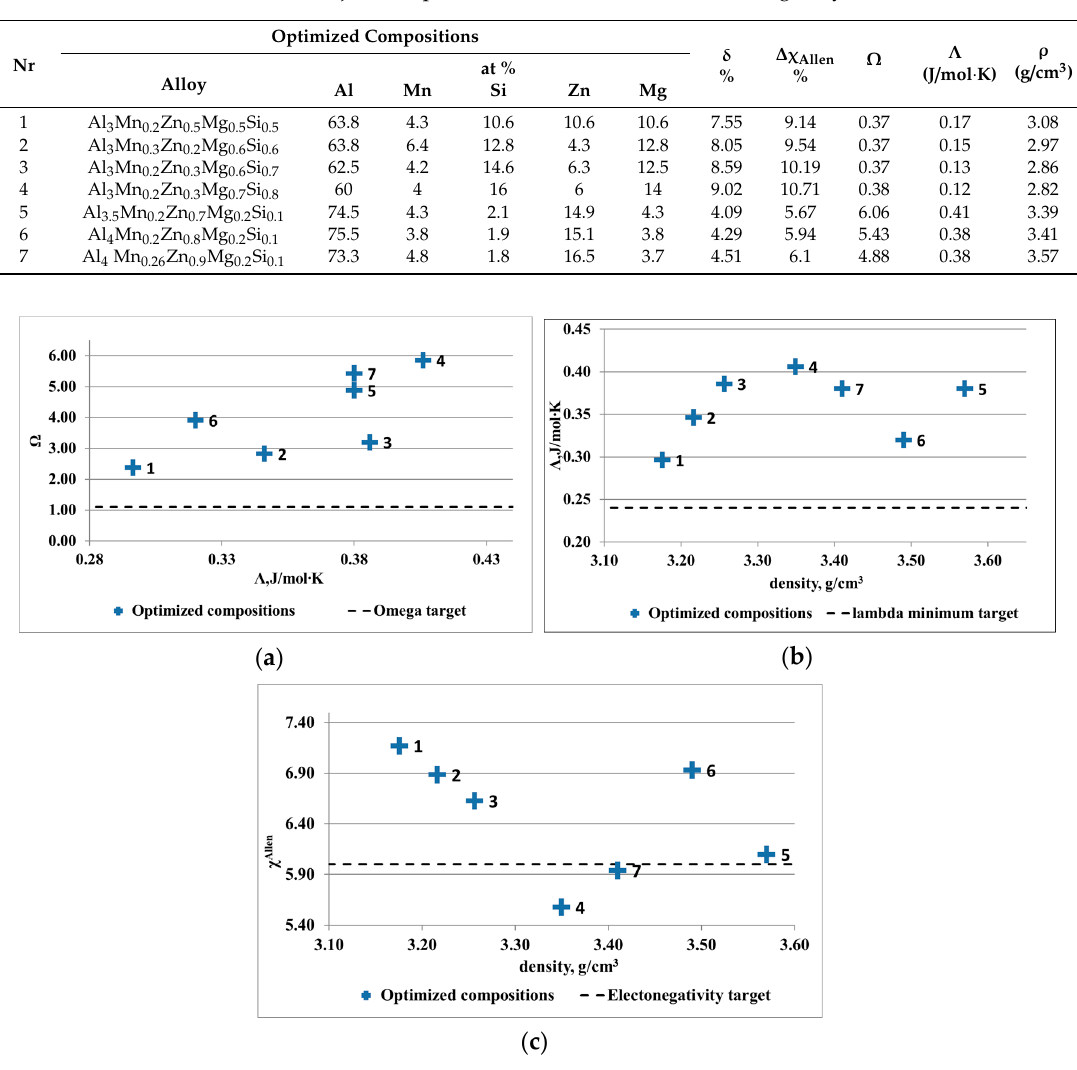
Figure 3. Results of criteria multiobjective optimization for Al-Cu-Si-Zn-Mg system: ( a ) Λ versus Ω , ( b ) Λ versus density, and ( c ) ∆χ Allen versus density. Table 3. Multiobjective optimization results for Al-Mn-Zn-Mg-Si system